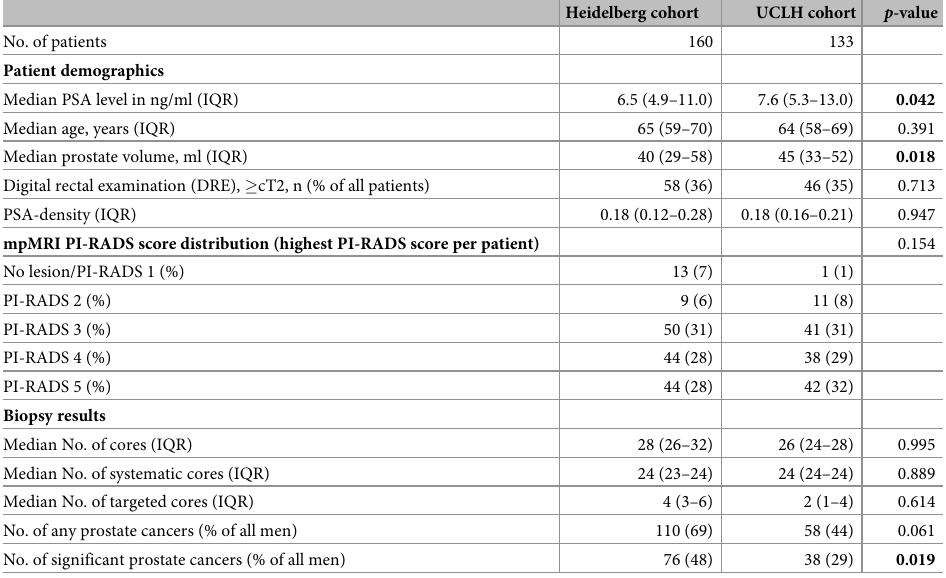
Table 2. Study population and results according to START criteria dichotomized into different cohorts. Differ- ences in subgroups of UCLH and Heidelberg University Hospital for patient demographics, mpMRI PI-RADS scoring and biopsy results.